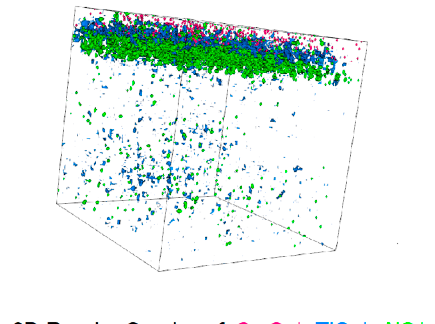
Figure 4. A reconstructed 3D model of the TiAlCrSiYN/TiAlCrN coating for surface oxides after 45 min of annealing at 700 °C. (length of the X and Y axes is 50 µm, length of the Z axis is 670 nm) .